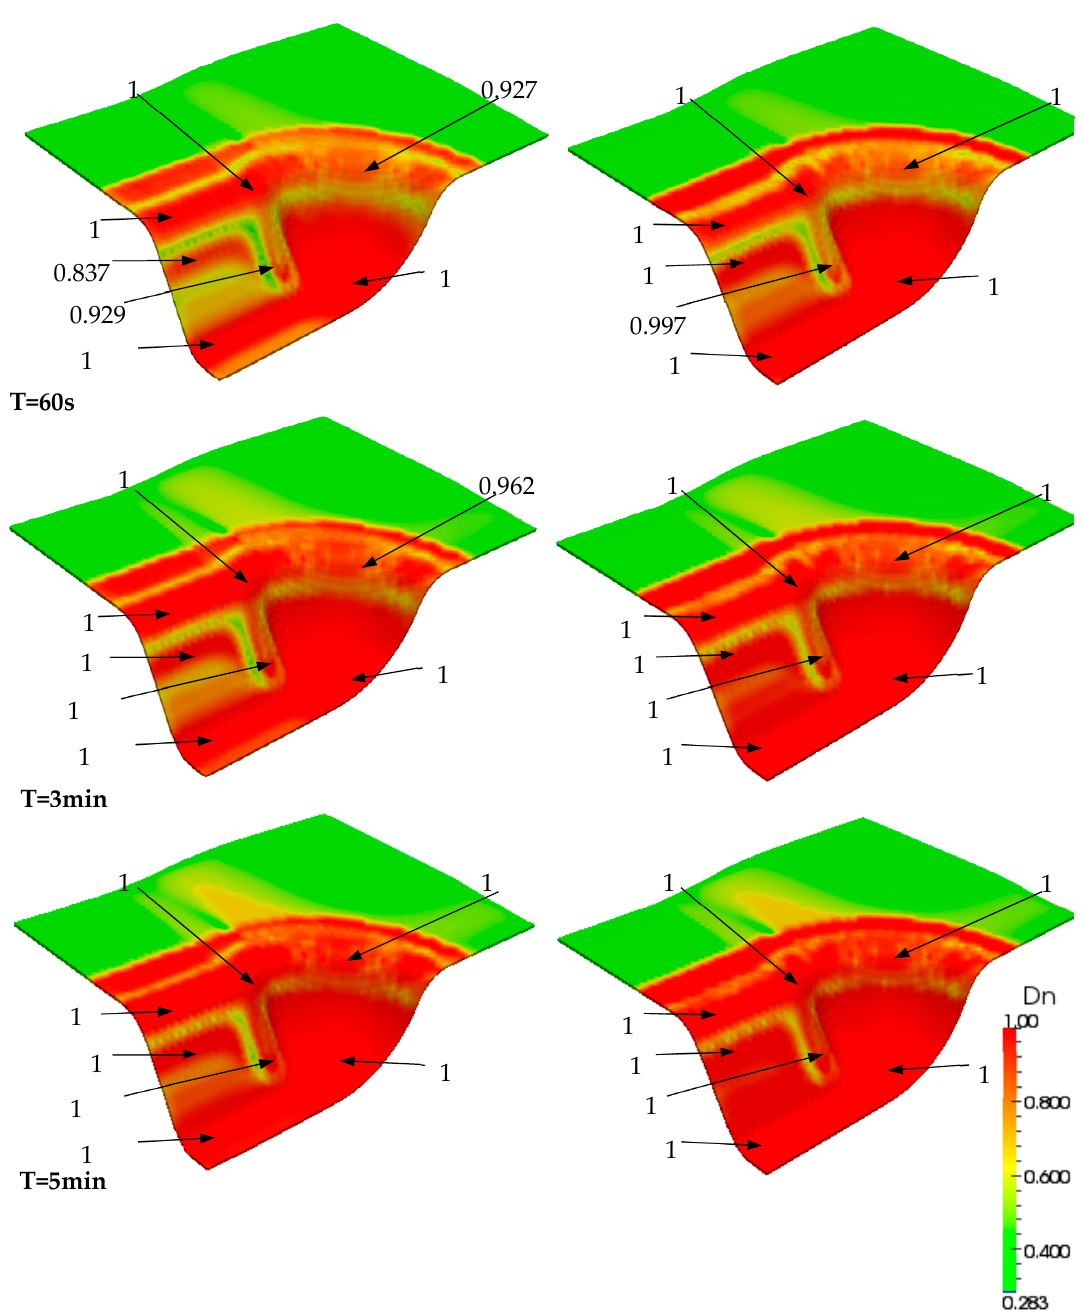
Figure 14. Comparison between two simulation results under a compaction displacement of Δ u = 0.2 mm (left) and Δ u = 0.5 mm (right) after 30 s up to 5 min.